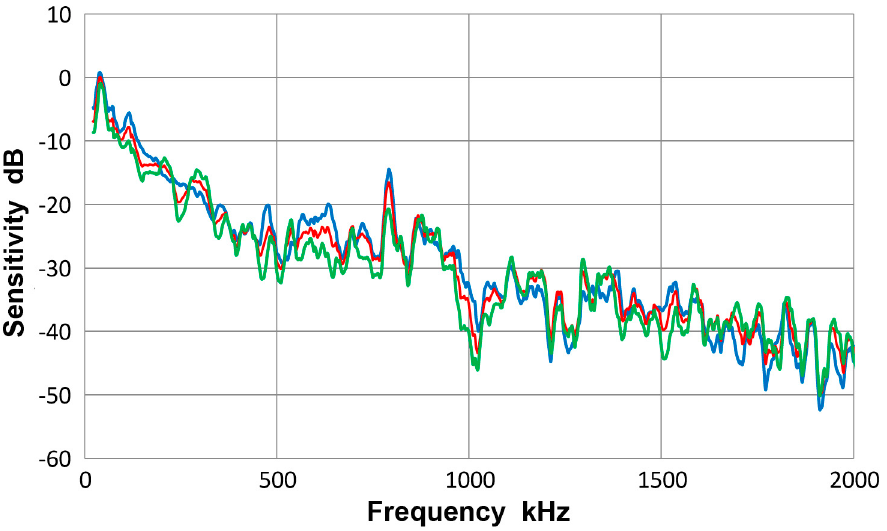
Figure 9. Receiving sensitivity of Olympus V103 transducer. Red -averaged guided wave sensitivity, blue -Lamb and bar waves from symmetric excitation (S) for 12.7 and 6.4 mm plates and bars, green -bar waves from asymmetric excitation (A) for the same four plates and bars.